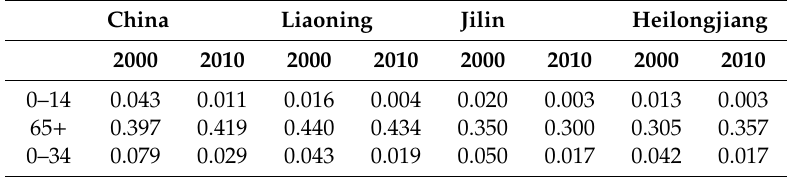
Table 3. Comparison of mortality rate between elderly population and young